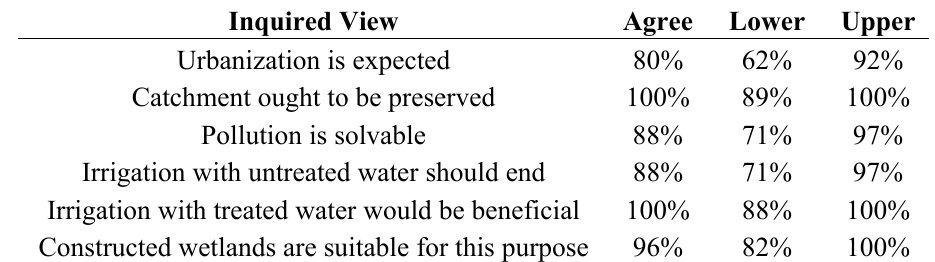
Table 3. Confidence interval for the stakeholder views about environmental preservation Inquired View Agree Lower Upper Urbanization is expected 80% 62% 92% Catchment ought to be preserved 100% 89% 100% Pollution is solvable 88% 71% 97% Irrigation with untreated water should end 88% 71% 97% Irrigation with treated water would be beneficial 100% 88% 100% 96% 82%